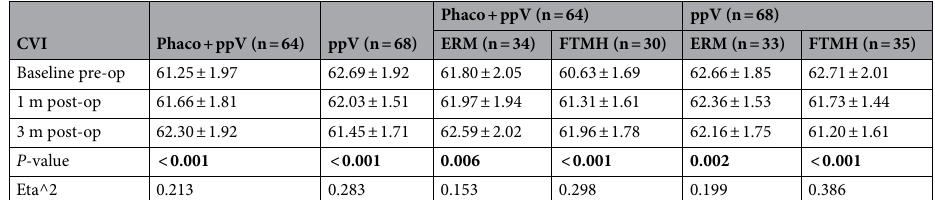
Table 2. Choroidal vascularity index (%) changes from baseline to 3 months post-op. Data are expressed as mean ± standard deviation (95% confidence interval). Repeated measures ANOVA tests and post hoc analysis. Statistically significant P -values are highlighted as bold. Abbreviations: ERM, epiretinal membrane; FTMH, full thickness macular hole; Phaco, phacoemulsification; ppV, pars plana